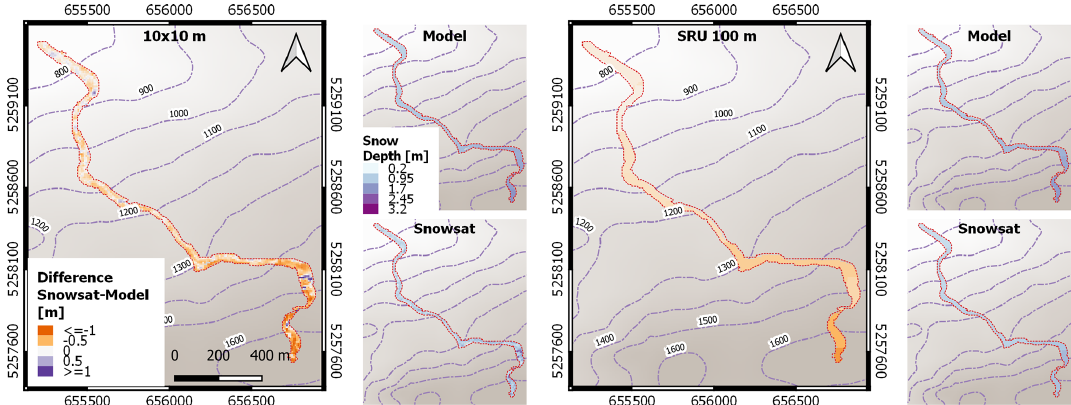
Figure 7. Example of spatial variability within a piste in Garmisch Classic (22 January 2018). On the left, RMSD represented as pixel-wise difference between measured and modeled snow depth for a 10m pixel resolution. The smaller figures represent the original modeled and measured snow depth. On the right, RMSD represented as averaged difference between measured and modeled snow depth for a 100m band SRU resolution. The nature of the large measured snow depth by GNSS at around 1400m elevation is due to a dip in the ground surface, which was filled with snow to level the piste. This led to a higher GNSS-measured snow depth compared to the